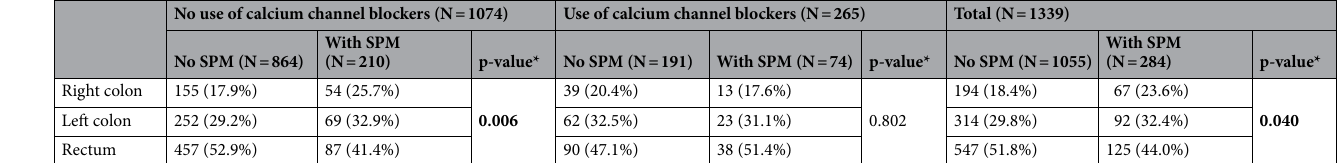
No use of calcium channel blockers (N = 1074) Use of calcium channel blockers (N = 265) Total (N =